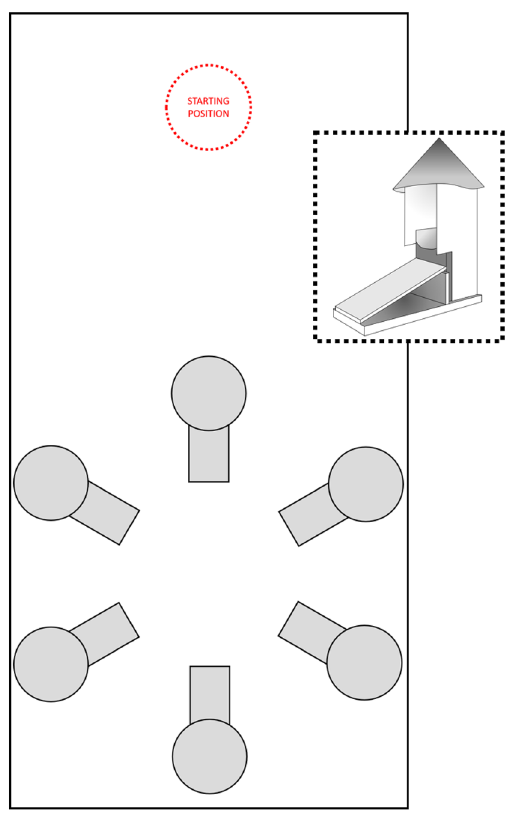
Figure 1. Top-down view of the inside of the experimental arena. The six feeders (in grey) were placed in a circular array in one half of the arena. The pigeon entered at the opposite side of the arena (the approximate location is marked in red). The insert in the broken-line box shows a 3D model of a